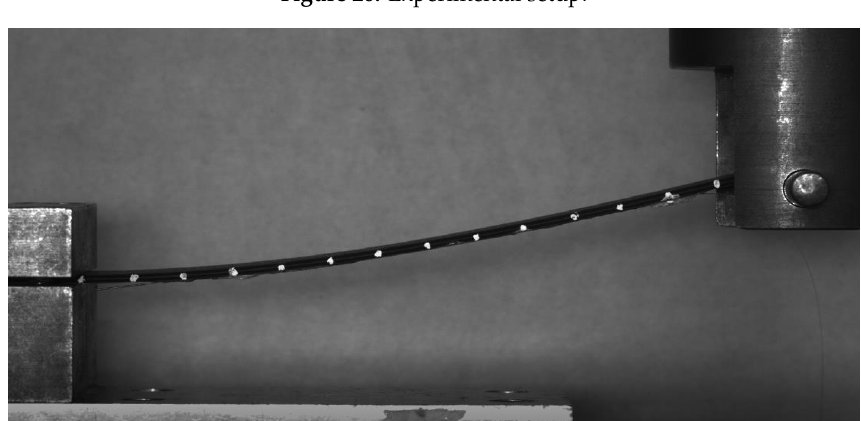
Figure 21. Experimental shape sensing with optical camera.